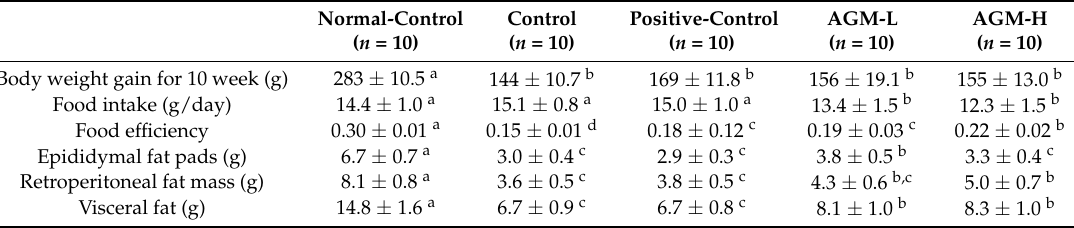
Table 2. Energy metabolism and visceral fat